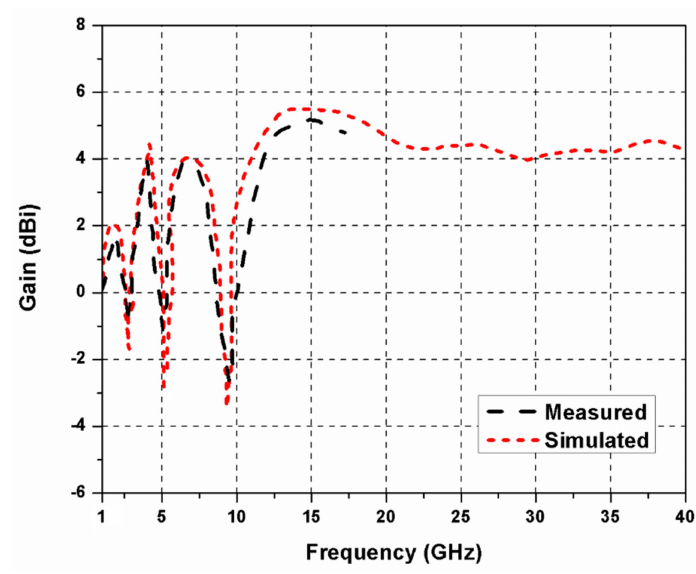
Figure 9. Simulated and measured gain of the SWB MIMO